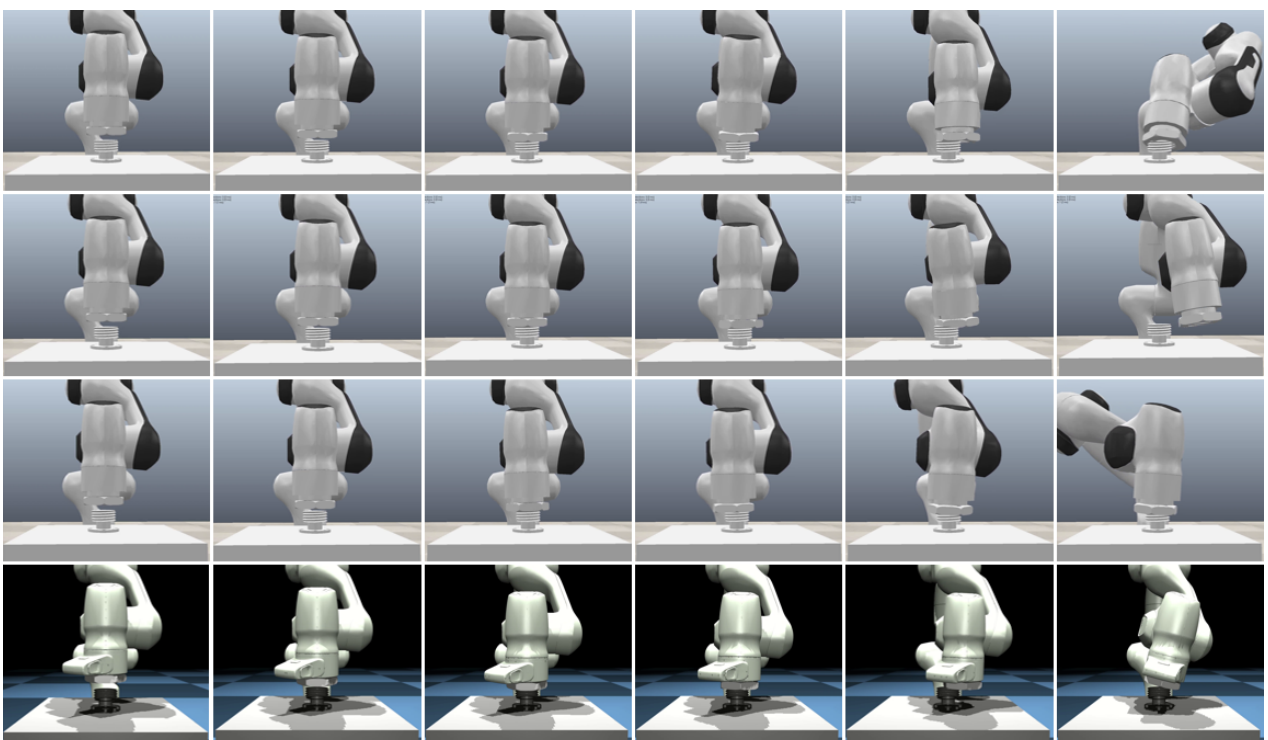
Figure 10. Snapshot of bolting scenario: ( first row ) ODE; ( second row ) Bullet; ( third row ) Vortex; ( fourth row ) MuJoCo.